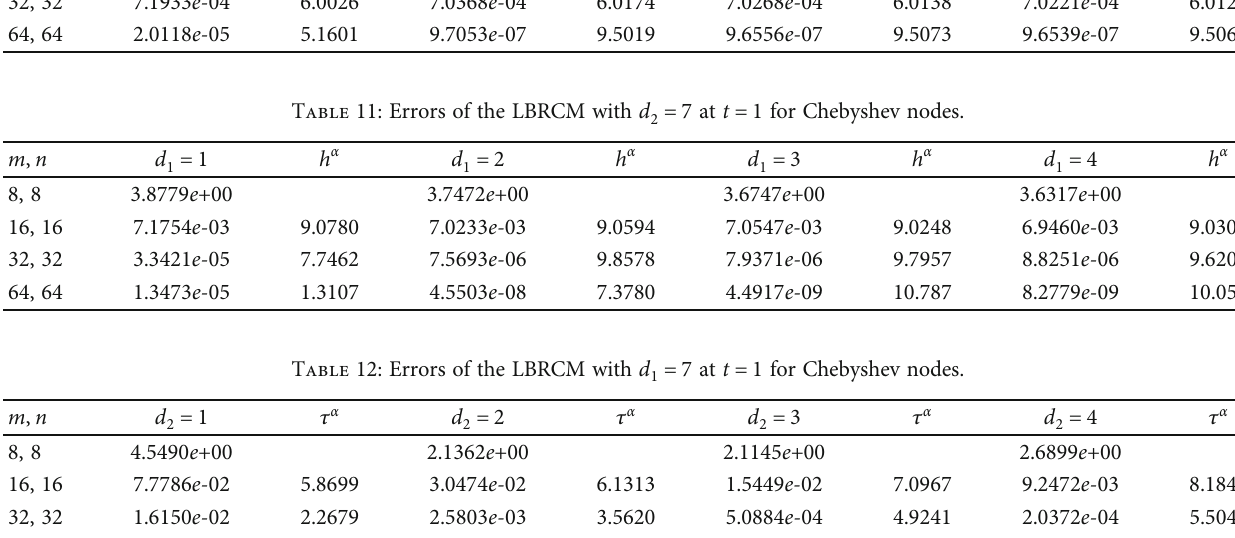
Table 11: Errors of the LBRCM with d